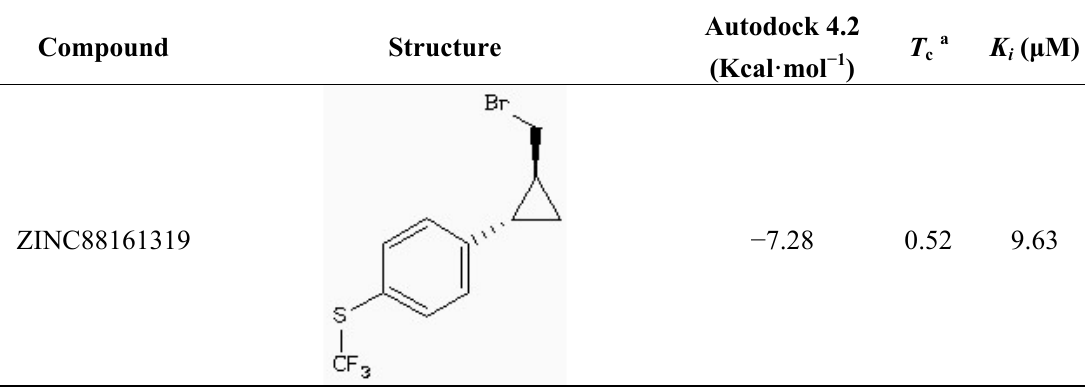
Table 5. The free binding energy among the inhibitors and